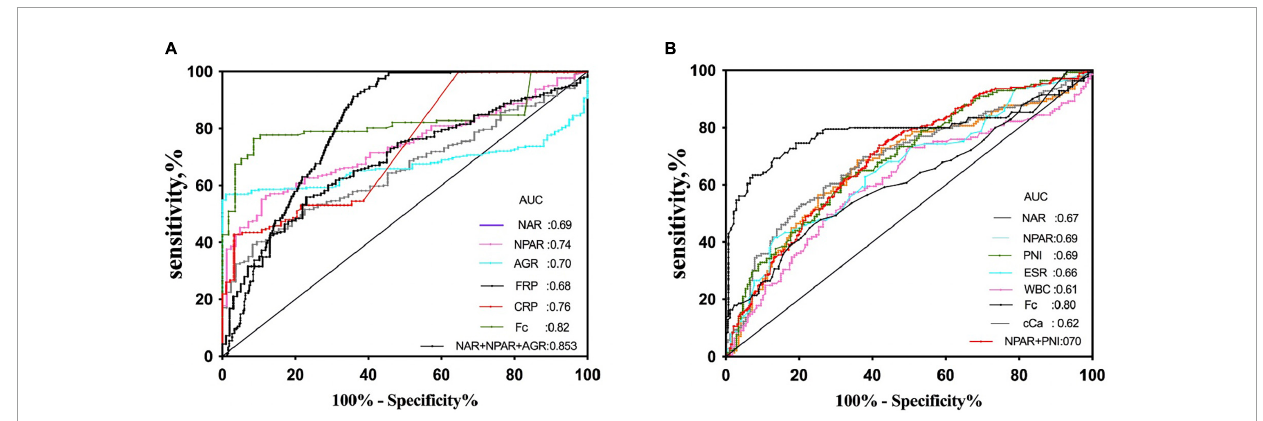
FIGURE2 Receiver operating curve analysis (ROC) of inflammatory- based markers in differentiating inflammatory bowel diseases (IBD) from the control group (A) ; active clinic stage from inactive group in patients with IBD (B) .